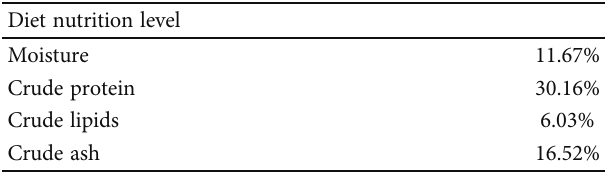
Table 1: Nutrition level of experimental diet